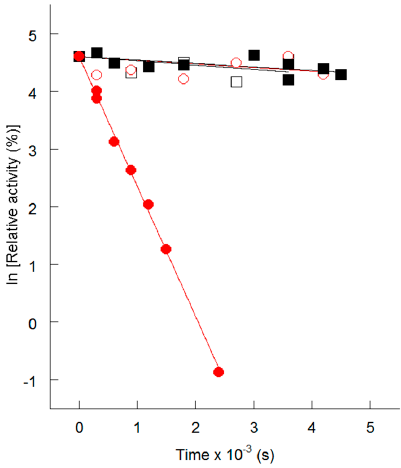
Figure 1. Thermal inactivation of His 6 - N - h CPT2 (open symbols) and His 6 - N - h CPT2/S113L (filled symbols) at 30 and 40 °C. Black squares show thermal inactivation at 30 °C, red circles represent values at 40 °C. The data is presented as time-dependent changes of natural-log-transformed relative activities.